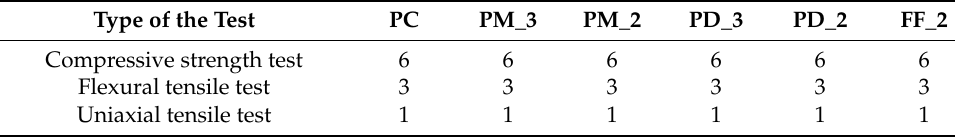
Figure 2. Casting of dog-bone specimens for uniaxial tensile test: ( a ) first layer of stirrups on the 1/3 depth of the sample; ( b ) second layer of stirrups on the 2/3 depth of the sample. Table 6. Research program–number of studied samples for performed tests.